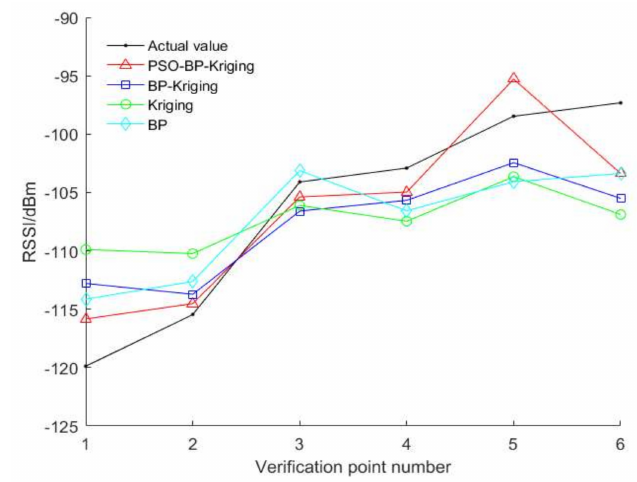
Figure 6. Comparison of interpolation